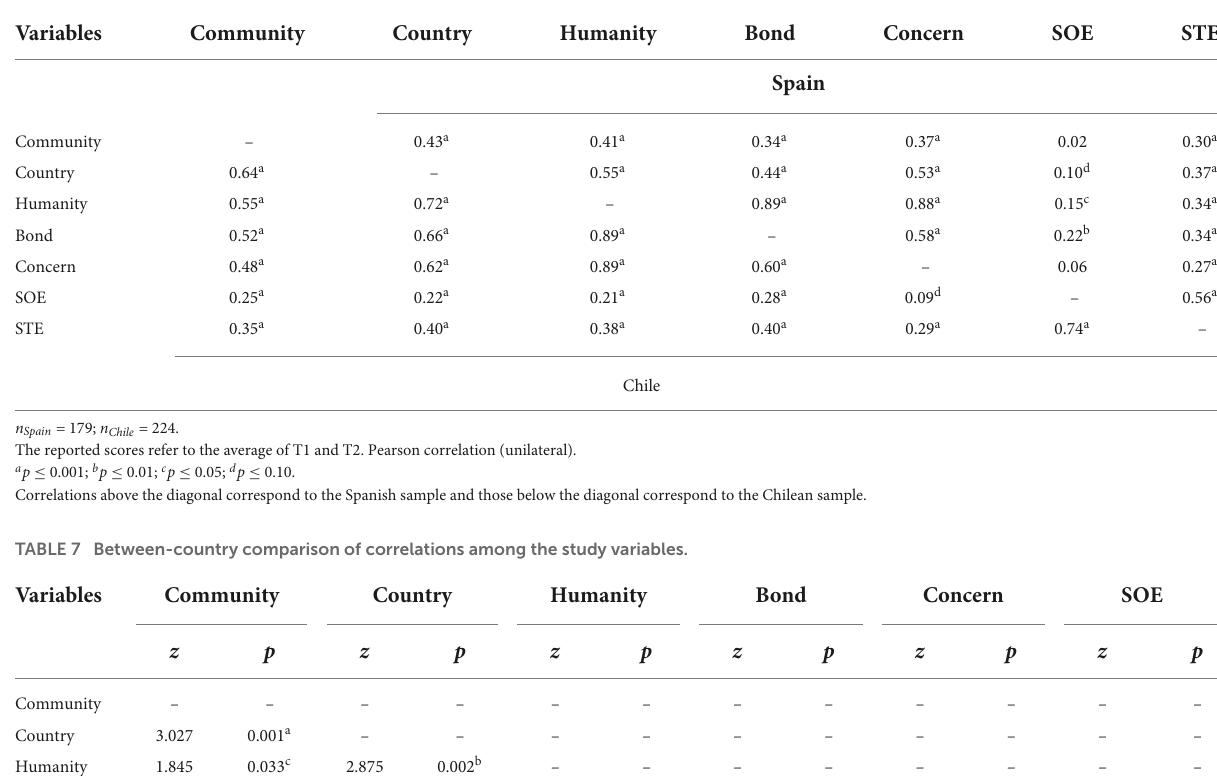
TABLE 6 Correlations of the study variables by country.